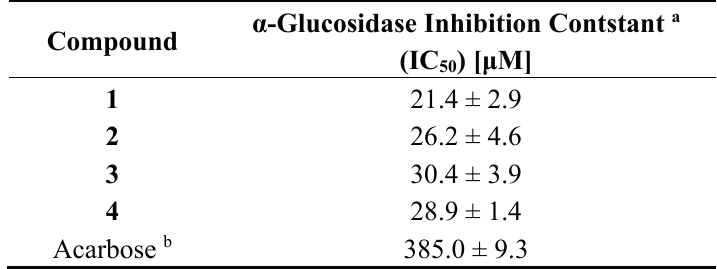
Table 2. α -Glucosidase inhibition of compounds 1 – 4